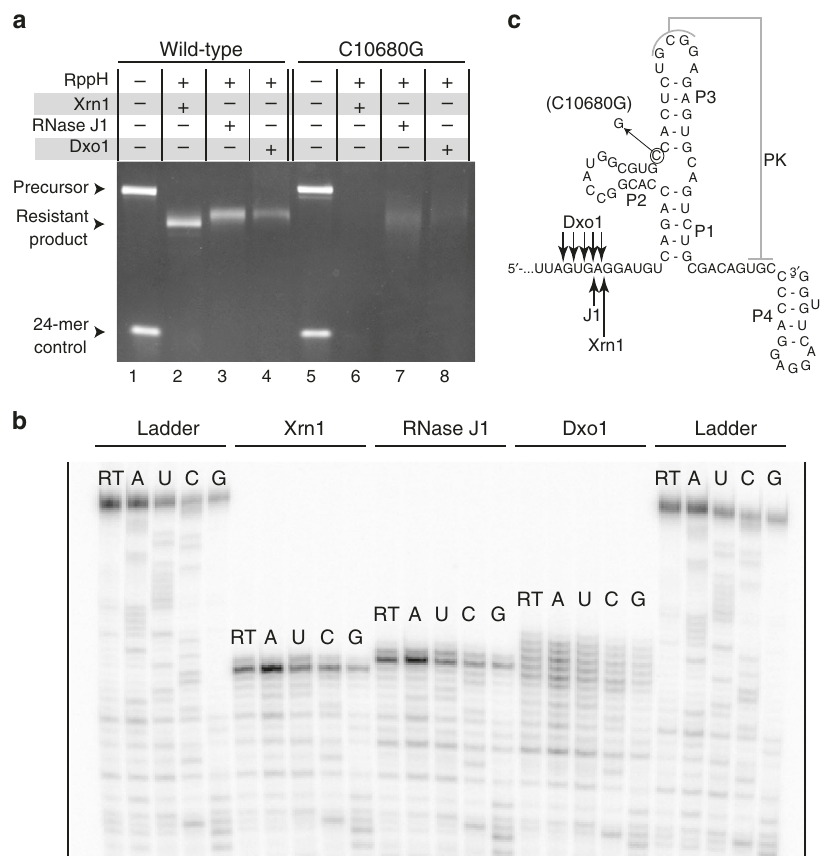
Fig. 2 Testing the mechanism of exoribonuclease resistance. a Exoribonuclease resistance assay of wild-type and mutant WNV xrRNA2, using different exoribonucleases. b Reverse transcription mapping of the halt sites of the exoribonucleases. c Secondary structure of the test xrRNA with the location of the point mutation and the halt sites for all of the exoribonucleases indicated. Gels are representative of greater than three independent